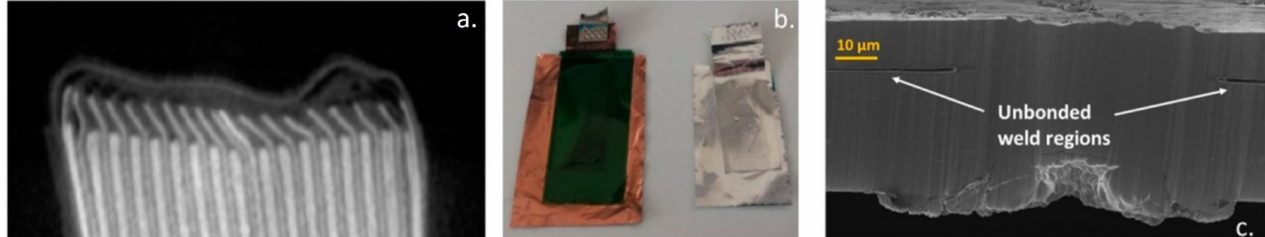
Figure 4. Observations of tab deformation and assembling and welding inconsistencies in the Samsung Galaxy Note 7 batteries: ( a ) X-ray CT scan of electrode deformation in the prismatic cell; ( b ) missing insulating tape on the cathode tabs; ( c ) SEM cross-section of an anode tab weld (CC BY Loveridge et al.